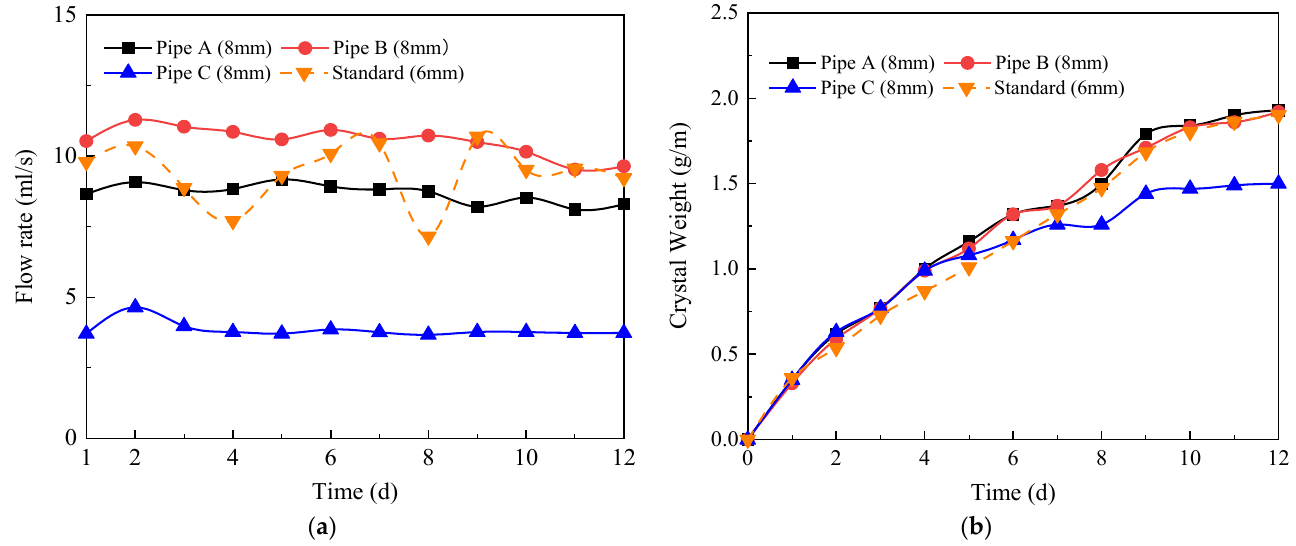
Figure 13. Variation of flow rates and crystallization rates of circular drainage pipes at different diameters. ( a ) Flow rate curves. ( b ) Crystallization rate curves.